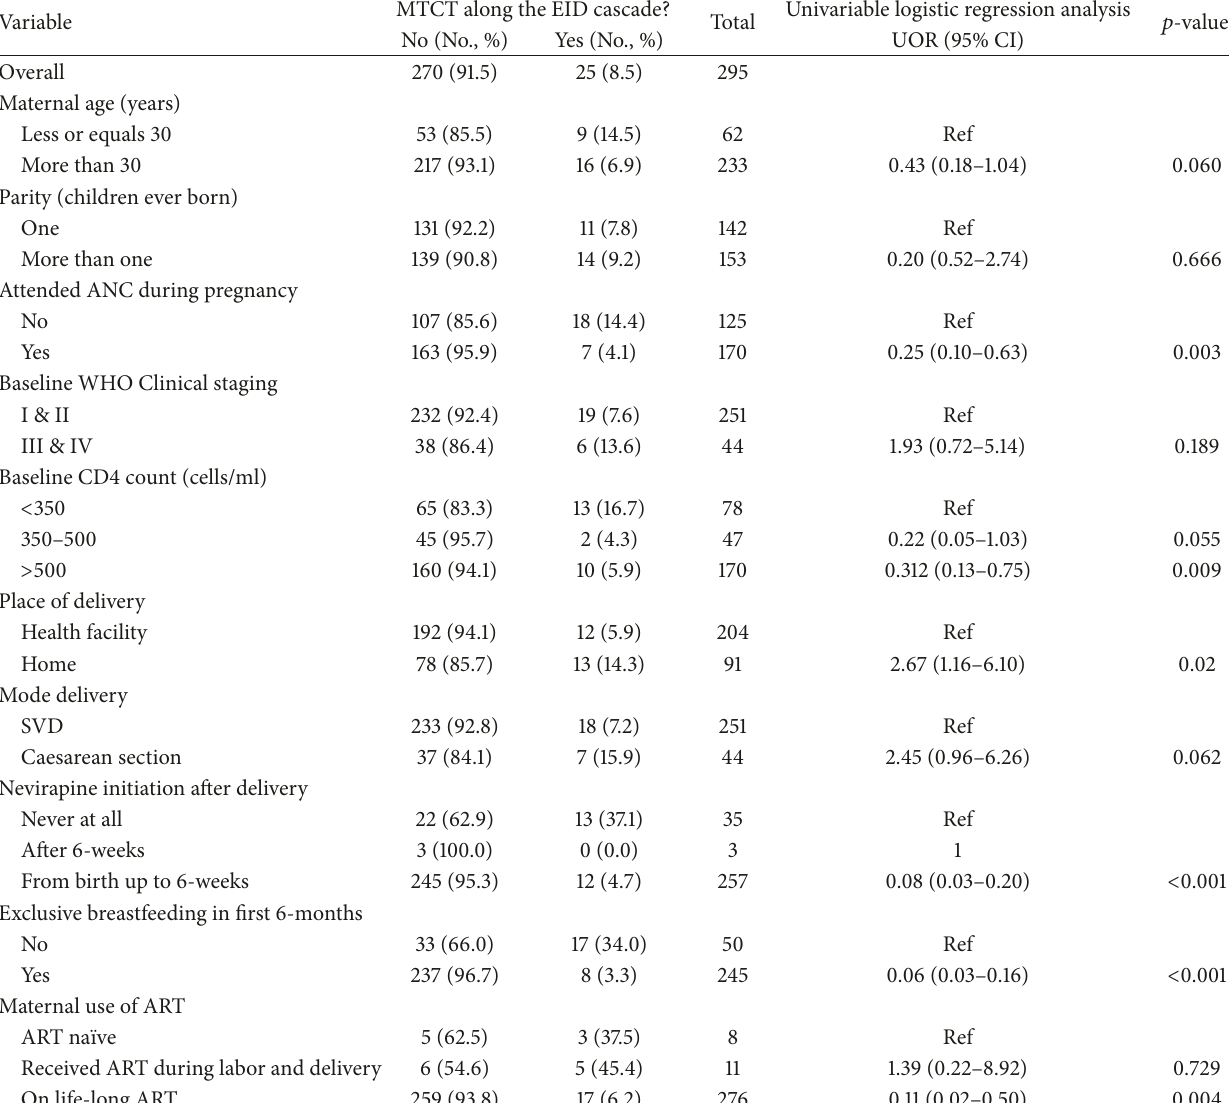
Table 2: Bivariate analysis of factors associated with MTCT at ARRH, Northwestern Uganda. MTCT along the EID cascade? Univariable logistic regression Variable Total